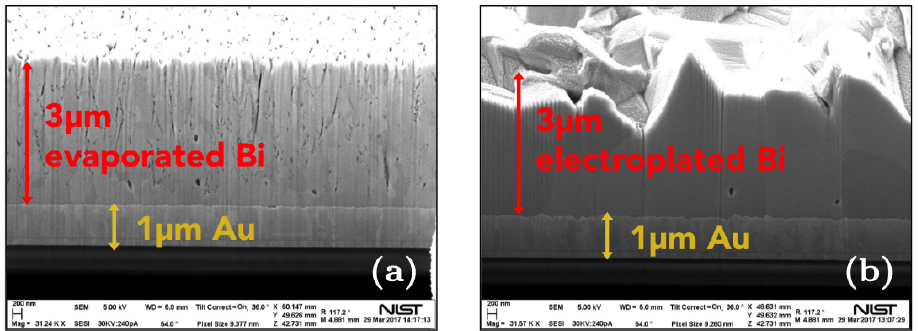
Figure 9. Scanning electron micrographs of the ( a ): evap-Bi and ( b ): elp-Bi absorber cross-sections. The evap-Bi grain appears smaller than that of the elp-Bi, and shows a columnar structure. Reprinted from [105] by permission from AIP Publishing. Copyright ©2017, AIP